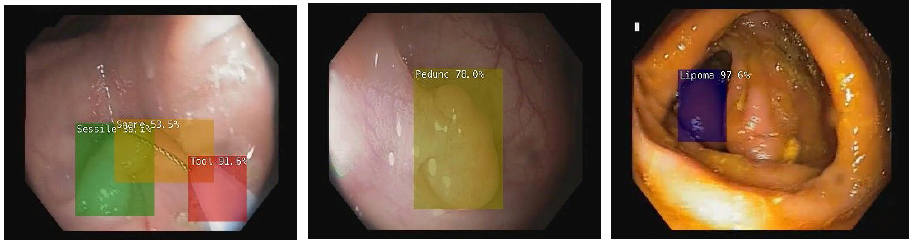
Figure 2. Examples of deep learning colonoscopy detection in real-time on an NVIDIA Jetson Xavier microsystem.